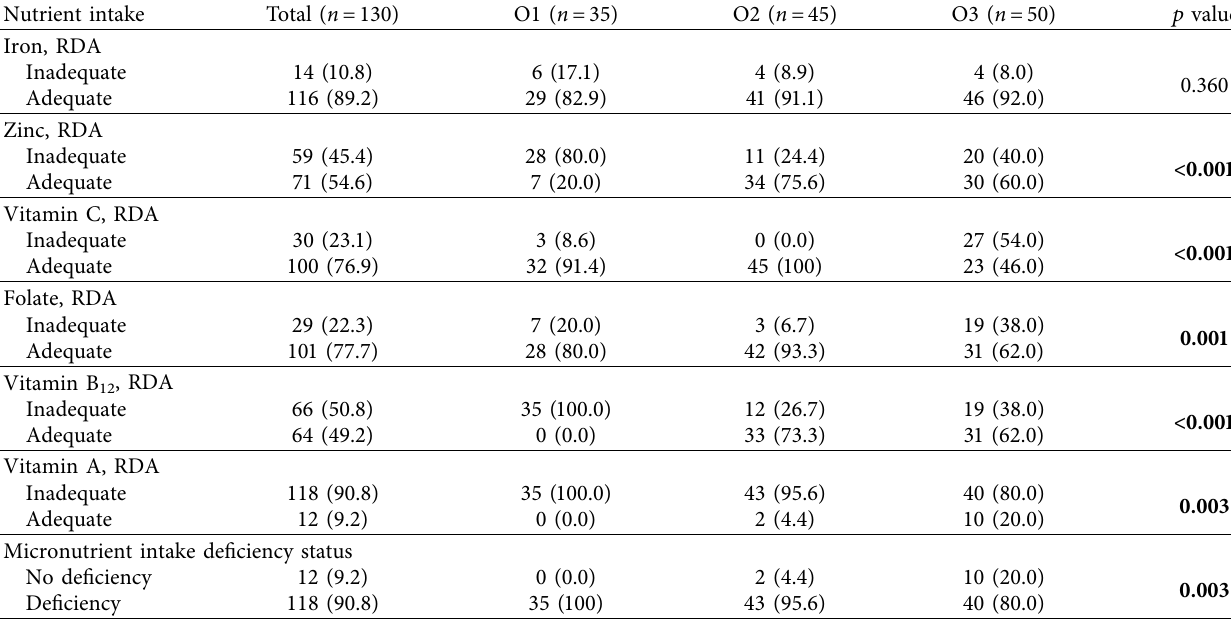
Table 3: Micronutrient intake of